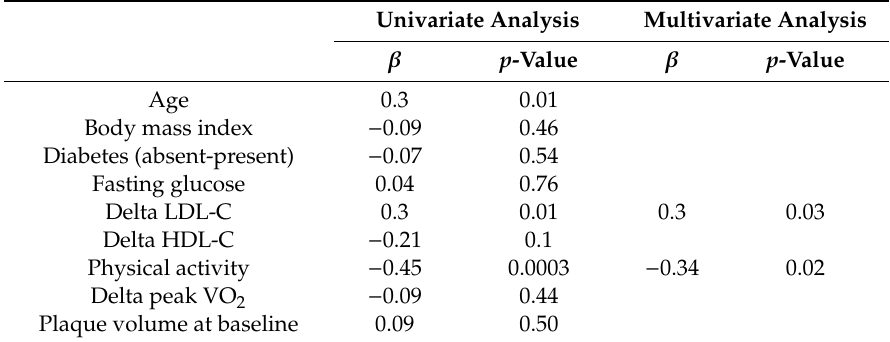
Table 4. Multiple linear regression analysis of factors on the percent change of plaque volume. Univariate Analysis Multivariate